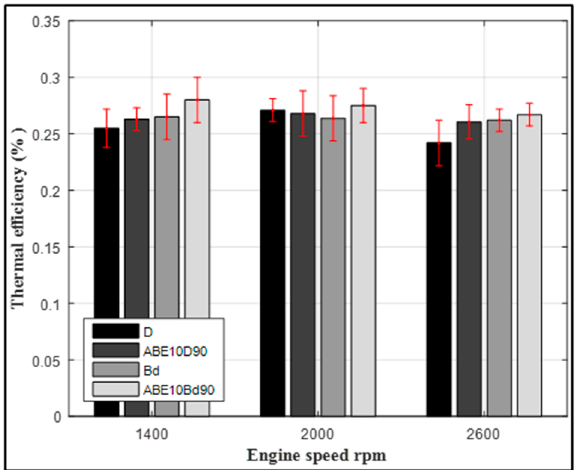
Figure 9. Thermal efficiency of test fuels.